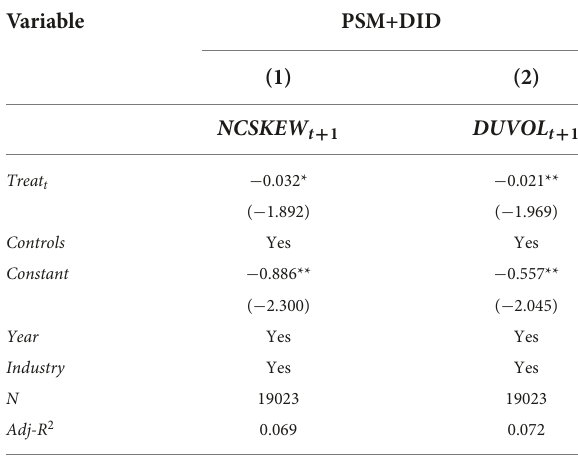
TABLE 3 Propensity score matching+DID method.